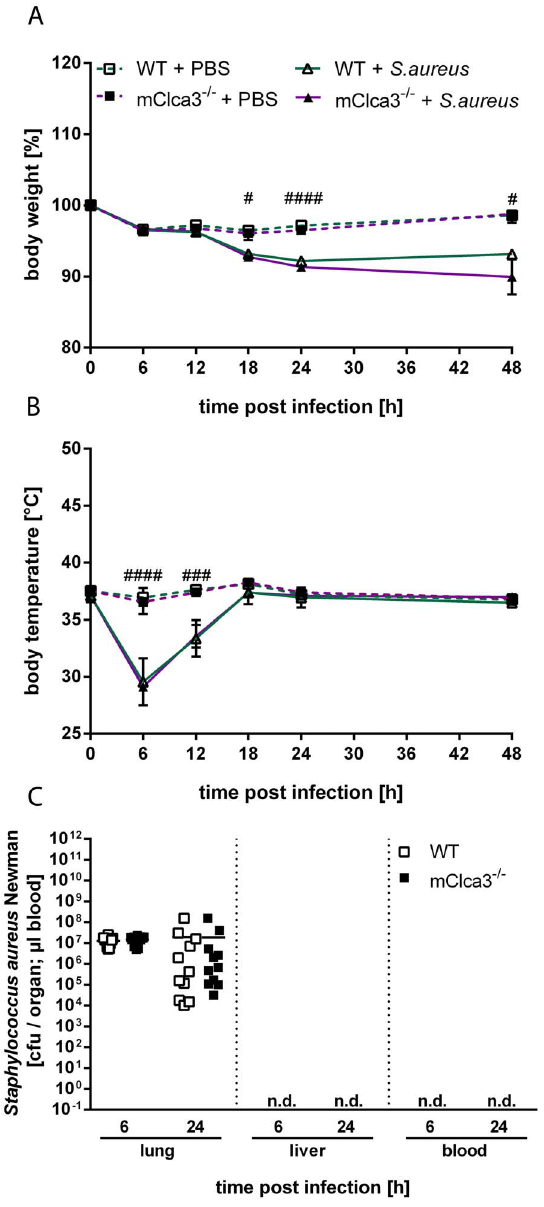
Figure 1. mCLCA3-deficiency had no impact on clinical outcome of pneumonia or bacterial loads in lungs. mClca3 2 / 2 and WT mice were transnasally infected with 5 6 10 7 Staphylococcus aureus Newman or received PBS (controls) and body weights (A) and temperatures (B) were measured every 6 hours for 24 hours and once after 48 hours. Values are given as mean 6 SEM (n=8 each group). # p , 0.05, ## p , 0.01, ### p , 0.001, #### p , 0.0001 versus the PBS control group. (C) Lung, liver and blood bacterial loads were determined 6 hours and 24 hours after infection. Values are given as individual data and mean (n=11 each group). n.d. = not